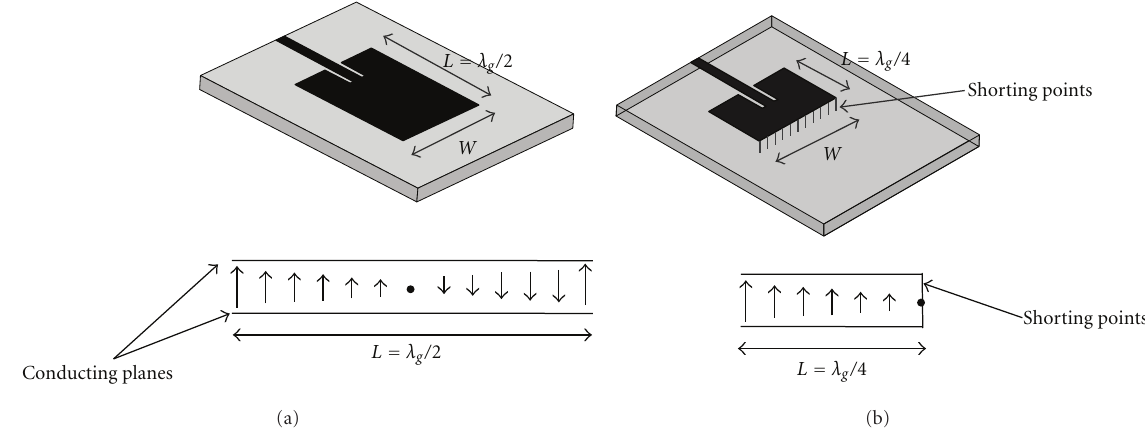
Figure 2: Example of elementary half (a) and quarter wave (with shorting points) (b) patch antennas. Electric field distributions along the antenna lengths.